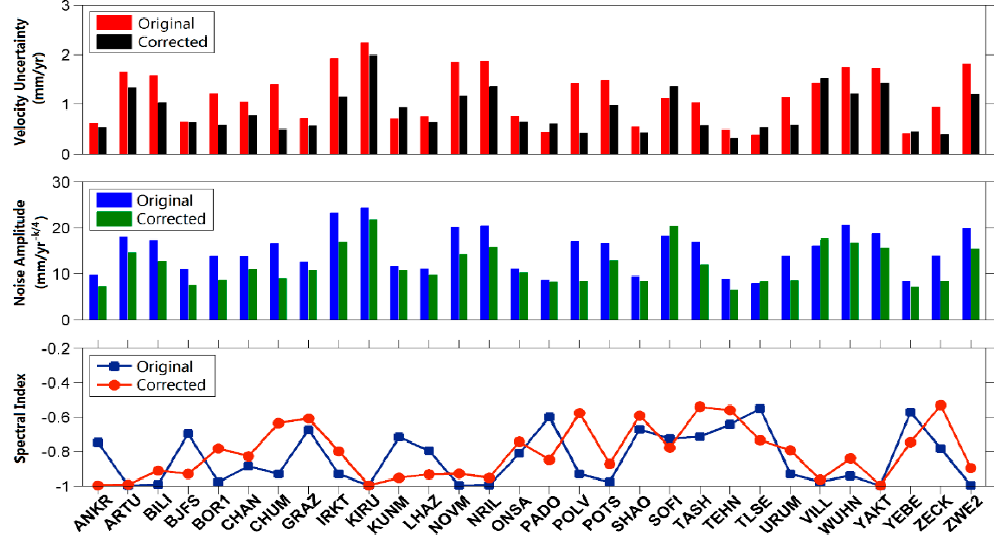
Figure 6. Comparison of the velocity uncertainty and noise parameters before and after AOH corrections.